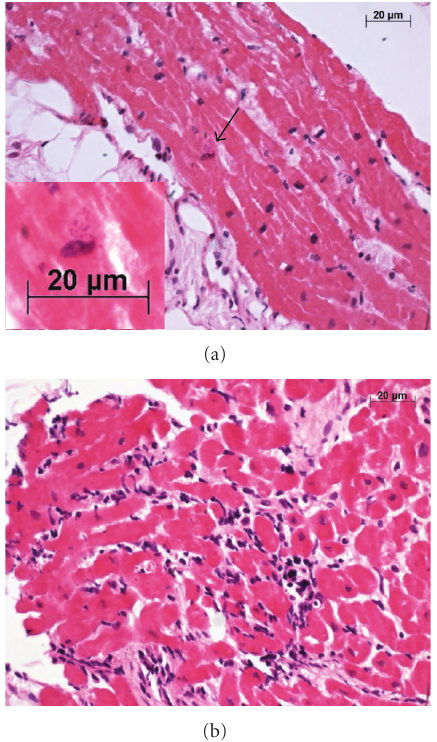
Figure 1: Photomicrographs of the endomyocardial biopsy. (a) In this region of the myocardium, a small Toxoplasma pseudocyst was noted in one cardiomyocyte (arrow). The inset shows ampli- fication of this area, as indicated by the arrow. The presence of round corpuscles consistent with T. gondii tachyzoites near the cardiomyocyte nucleus was noted. (b) In another region of the myocardium within the same endomyocardial biopsy sample, there were moderate amounts of mononuclear infiltrates with aggression and destruction of the cardiomyocyte. This led to the misdiagnosis of rejection, even though it was subsequently determined that this case of myocarditis was caused by T. gondii . ((a) and (b) Hematoxylin and eosin stain with objective × 40 in all images and digital zoom at the inset).